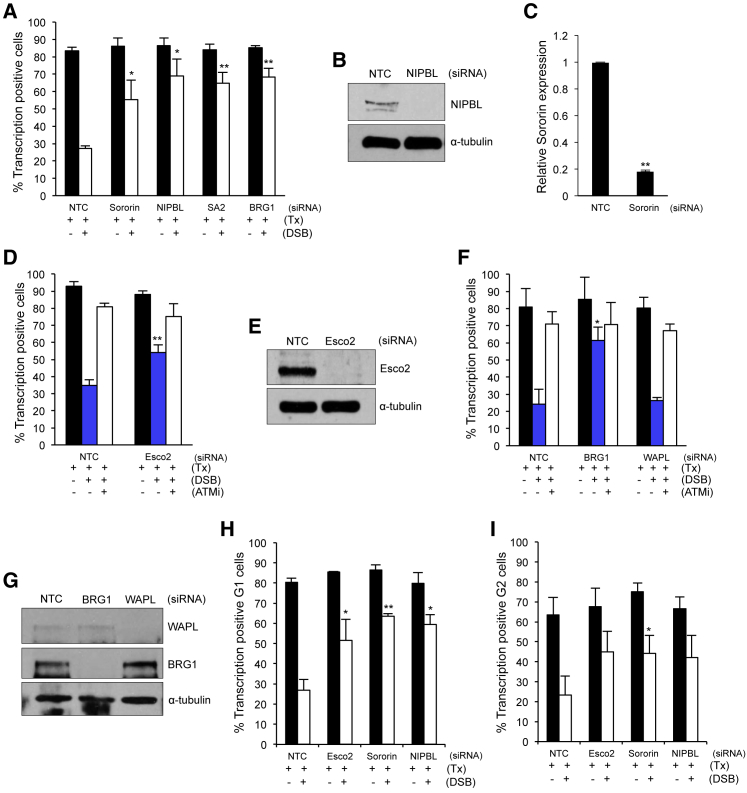
Cohesin Establishment and Loading Factors Are Important for Transcriptional Repression at DNA DSBs in Both G1 and G2 Phase Cells(A, D, and F) Quantification of transcription in asynchronous U2OS reporter cells with or without induction of the FokI endonuclease (DSB) treated with siRNA targeting Sororin, NIPBL, SA2, or BRG1 (A), Esco2 (D), BRG1 or WAPL (F), and/or with 10 μM ATM inhibitor (NTC, non-targeting control). 150 cells were analyzed per condition, per repeat. Data are presented as mean ± SD; n = 3 (A), n = 4 (D), n = 4 (F) biological repeats.(B, E, and G) Western blot analysis of whole-cell extracts prepared from cells treated with siRNA targeting NIPBL (B), Esco2 (E), or BRG1 or WAPL (G). NTC, non-targeting control. α-Tubulin was used as a loading control.(C) qRT-PCR analysis of Sororin mRNA levels following siNTC or siSororin treatment to provide an indication of depletion efficiency.(H) Quantification of transcription in cyclin-D1-positive (G1 phase) U2OS reporter cells treated with the indicated siRNAs. Data are presented as the mean ± SD; n = 3 biological repeats.(I) Quantification of transcription in CENPF-positive (G2 phase) U2OS reporter cells treated with the indicated siRNA with or without induction of the FokI endonuclease (DSB). More than 110 cells were analyzed per condition, per repeat. Data are presented as mean ± SD, n = 3 biological repeats.∗p < 0.05, ∗∗p < 0.01 using paired Student’s t test. See also Figure S3.